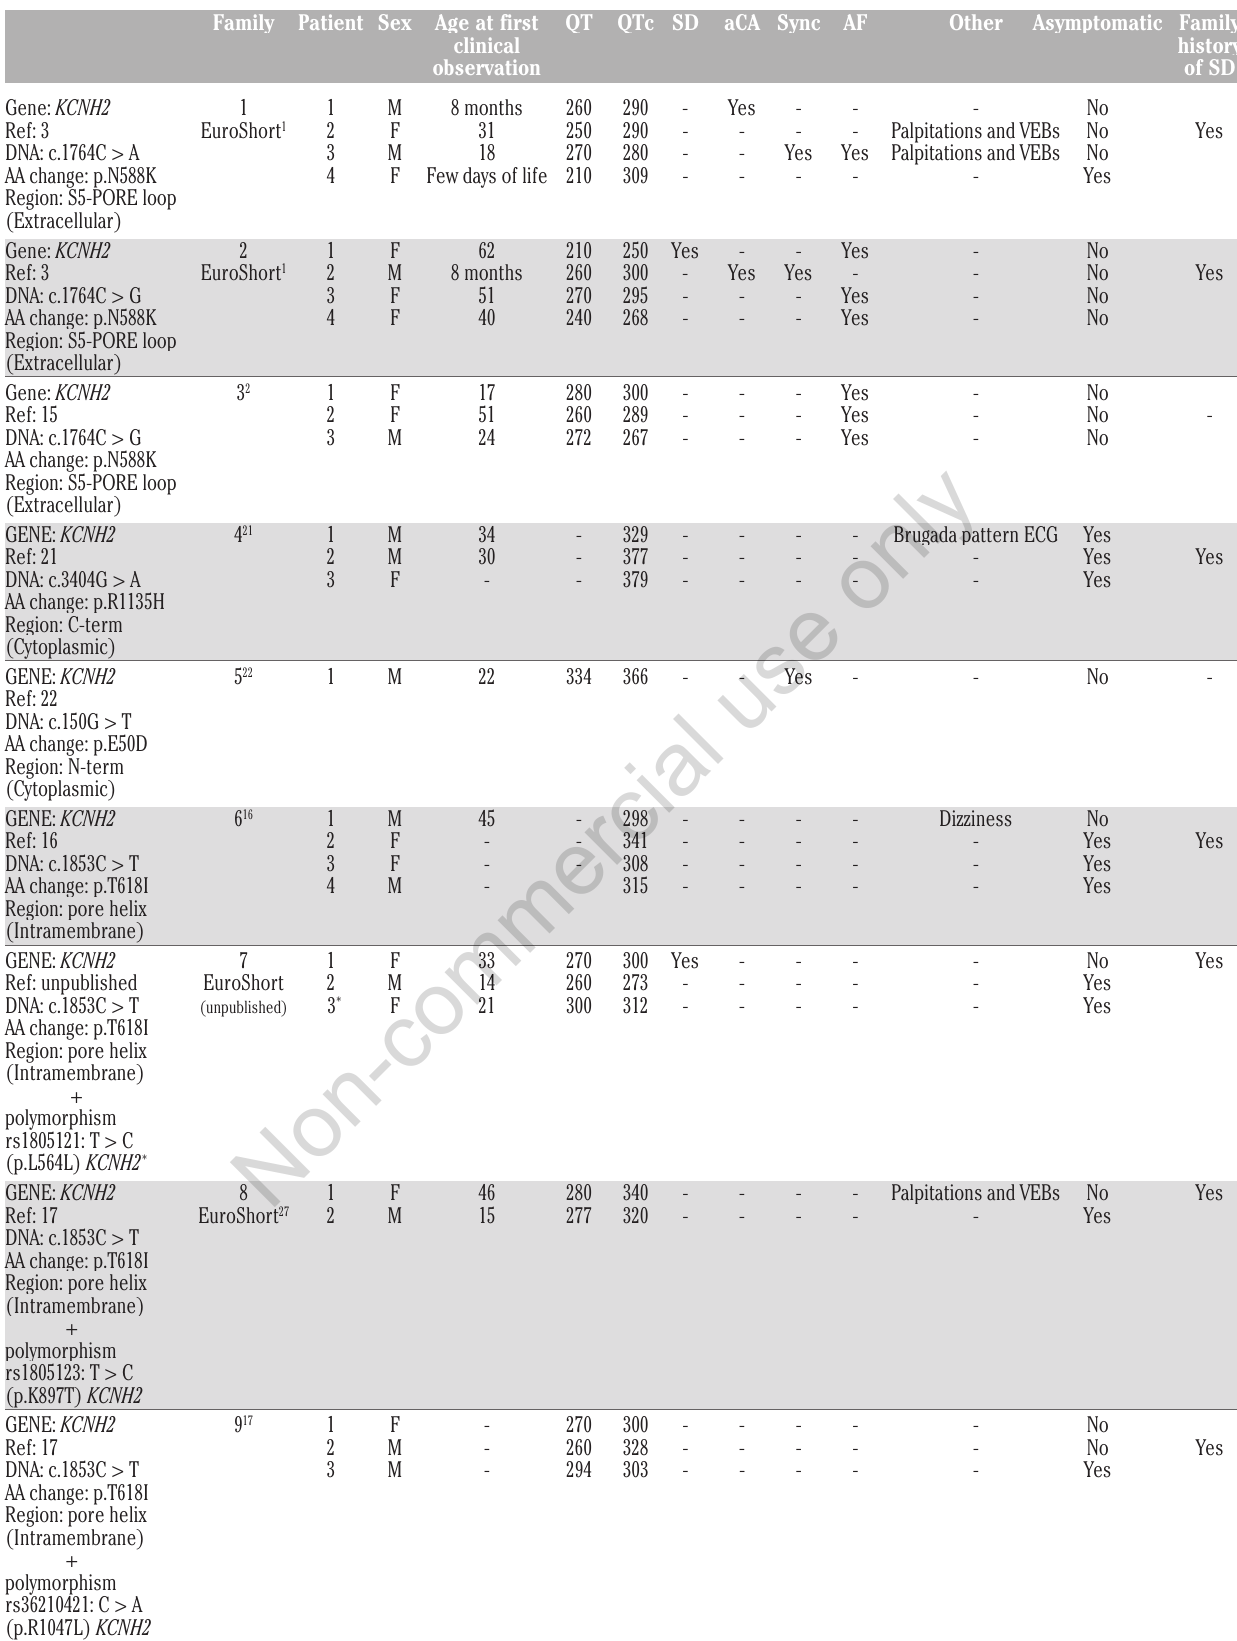
Table 1. Mutations in the potassium channel encoding-genes linked to short QT syndrome. For each subject QT/QTc interval, age at first clinical observation and clinical characteristics are reported. Family Patient Sex Age at first QT QTc SD aCA Sync AF Other Asymptomatic Family clinical history